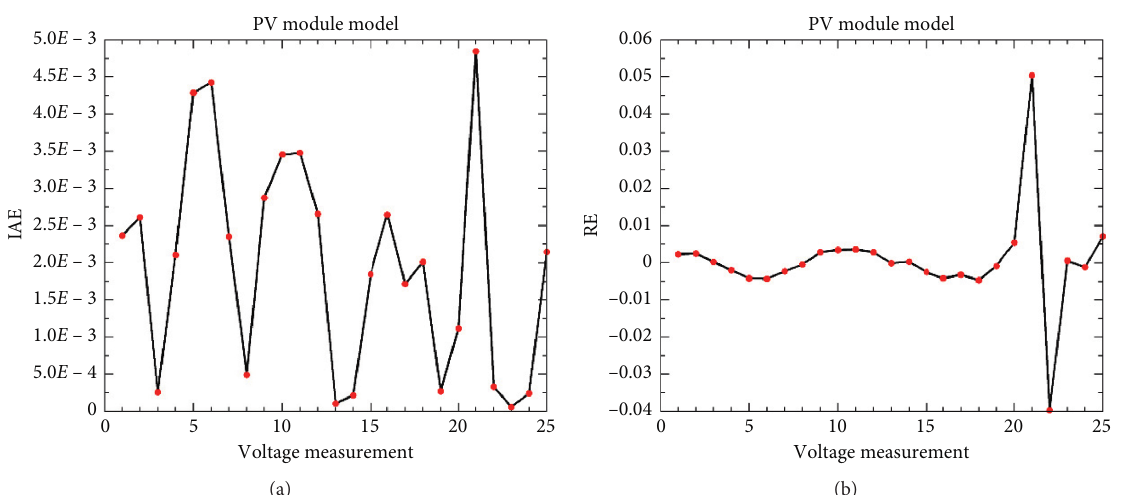
Figure 10: IAE (a) and RE (b) between the simulated data by PV module model and the experimental